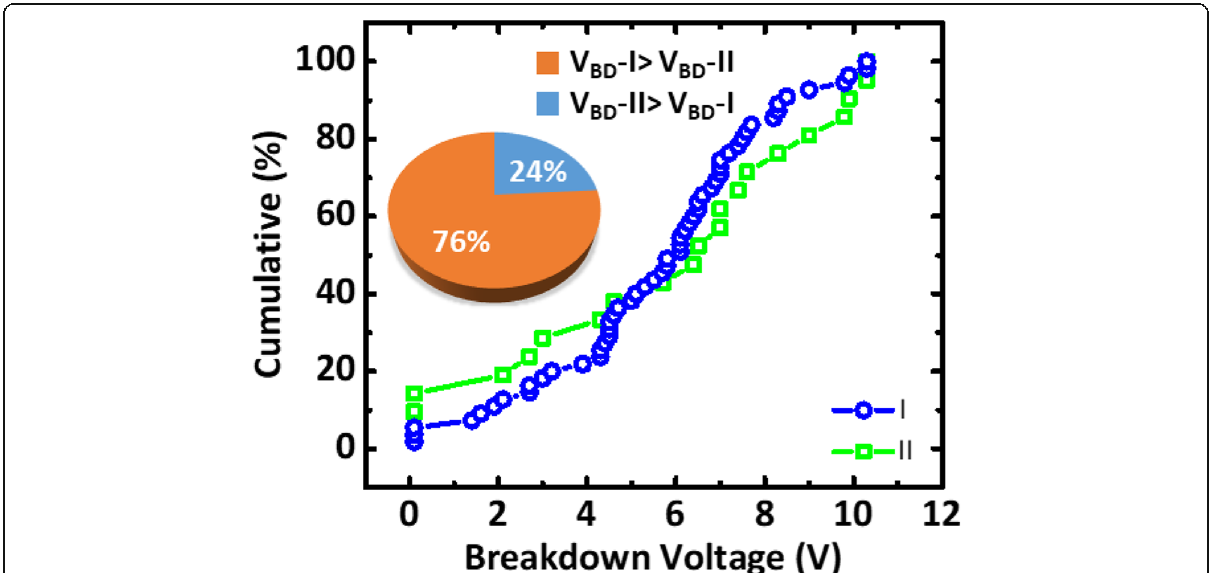
Fig. 7 Comparison of cumulative distribution of V BD from 60 dies across wafer and the portion of samples showing higher breakdown voltages from pattern I vs. that from pattern II